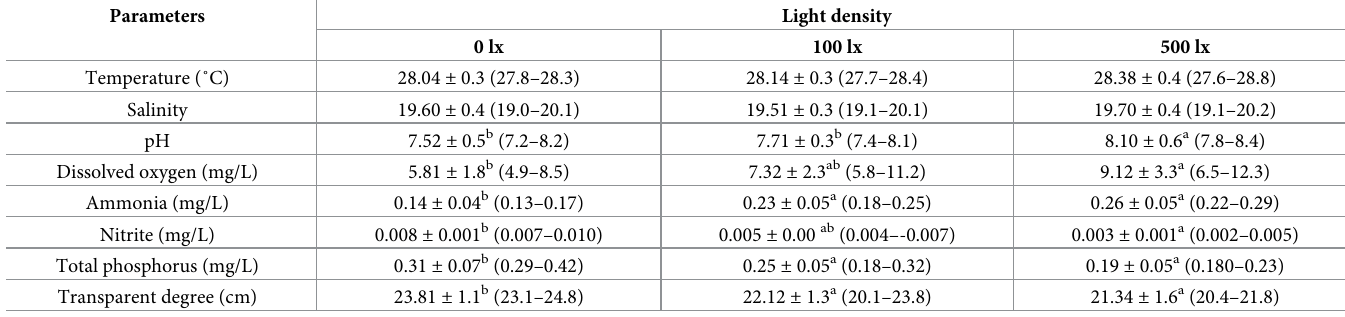
Table 2. Water quality parameters of the three light treatment groups after 15 consecutive days (mean ± SE and range of variation of 3 tanks). Parameters